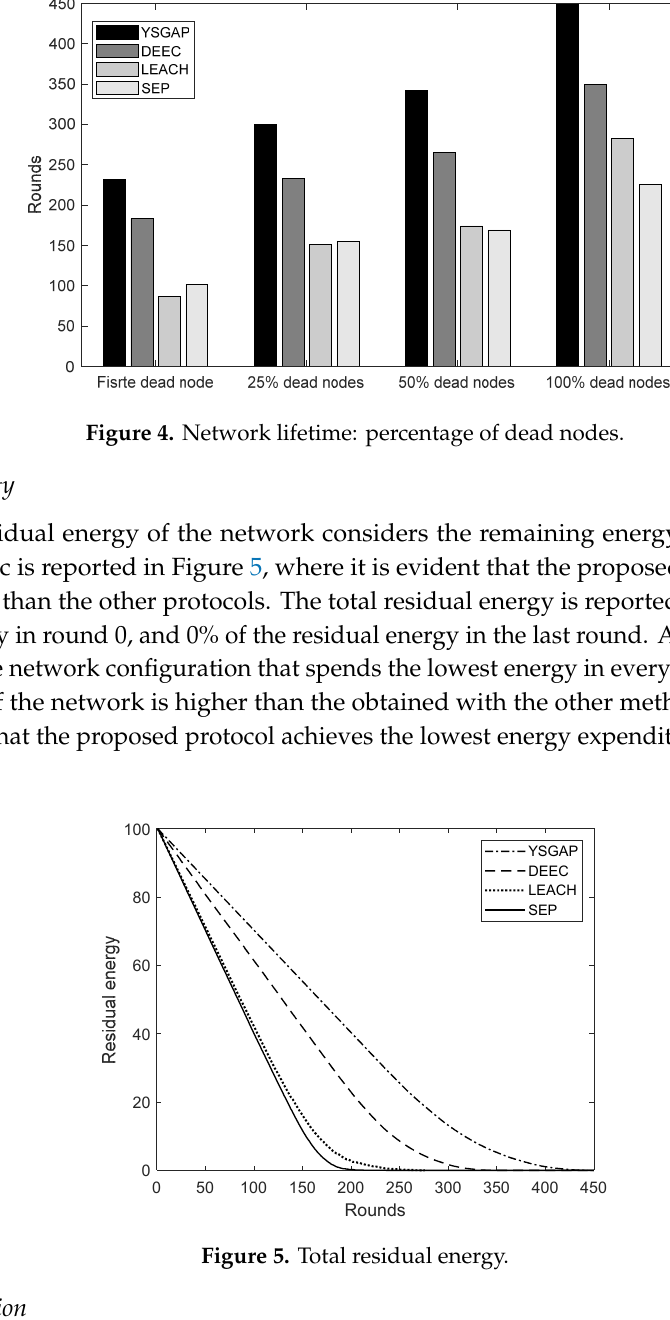
For a closer inspection, Figure 4 shows in which round has died the first sensor node.